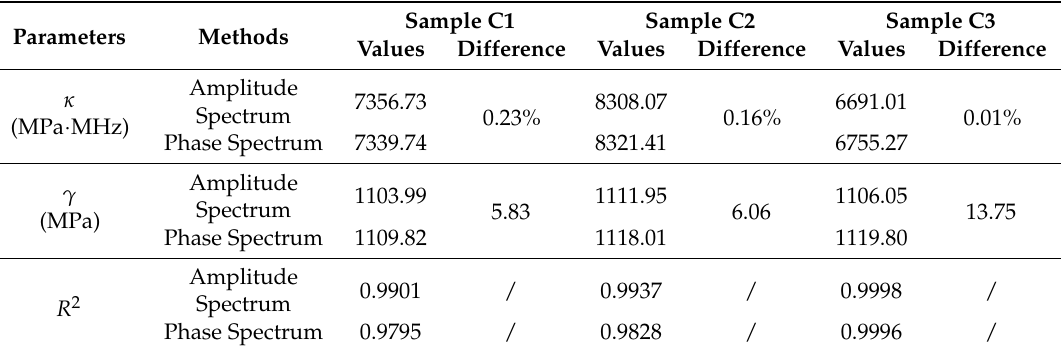
Table 1. Coefficients of the fitting line using the amplitude spectrum and the phase